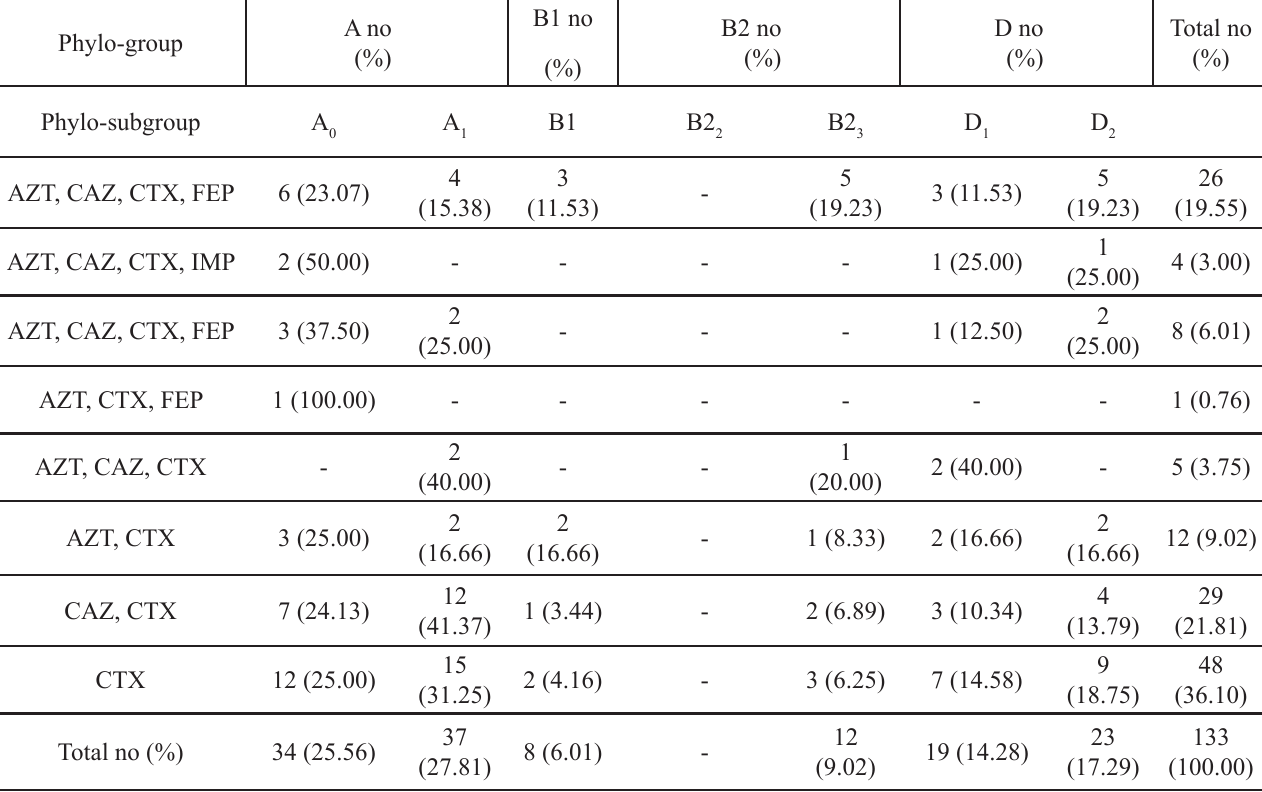
Table 3: Distribution of antibiotic resistance patterns in detected phylo-group/subgroups